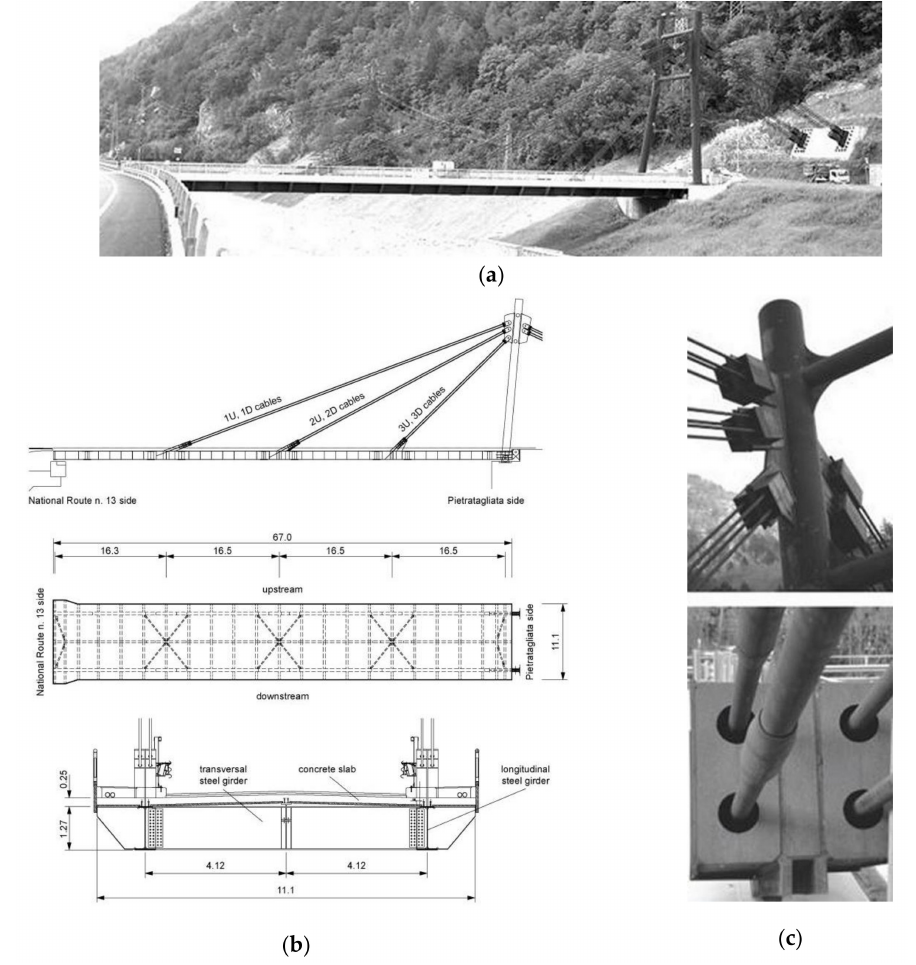
Figure 4. Pietratagliata Bridge (Italy): ( a ) general view; ( b ) technical drawings with lateral view, plan, and transversal cross-section; ( c ) stays-to-tower and stays-to-deck connection details (dimensions in meters). Figures reproduced from [44] with permission from Springer Nature, Copyright © license agreement no. 4386400703508 (July